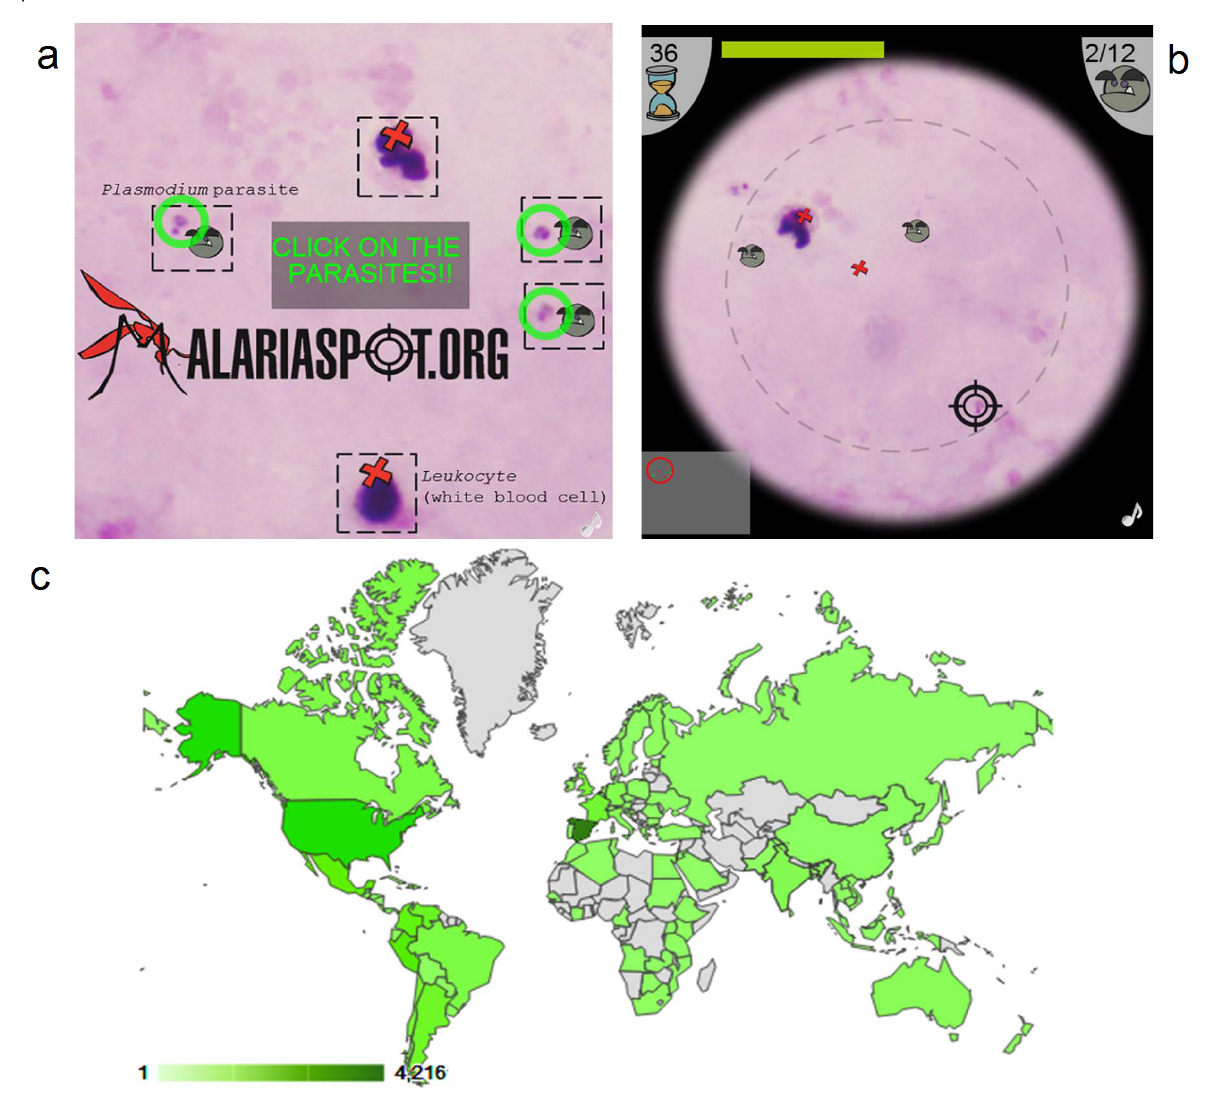
Figure 1. MalariaSpot example screens and player distribution. (a) Splash screen of MalariaSpot game website showing the game instructions. (b) Example of MalariaSpot game screen. (c) Map showing the geographic distribution of players during the evaluation period (the darkness of the country is proportional to the number of